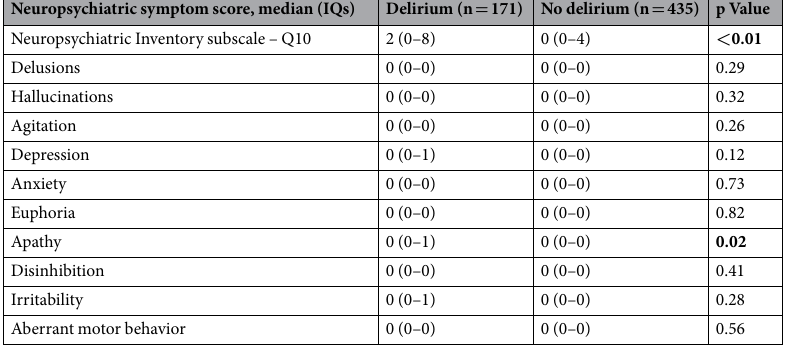
Table 2. Neuropsychiatric symptom score in patients with delirium and patients without